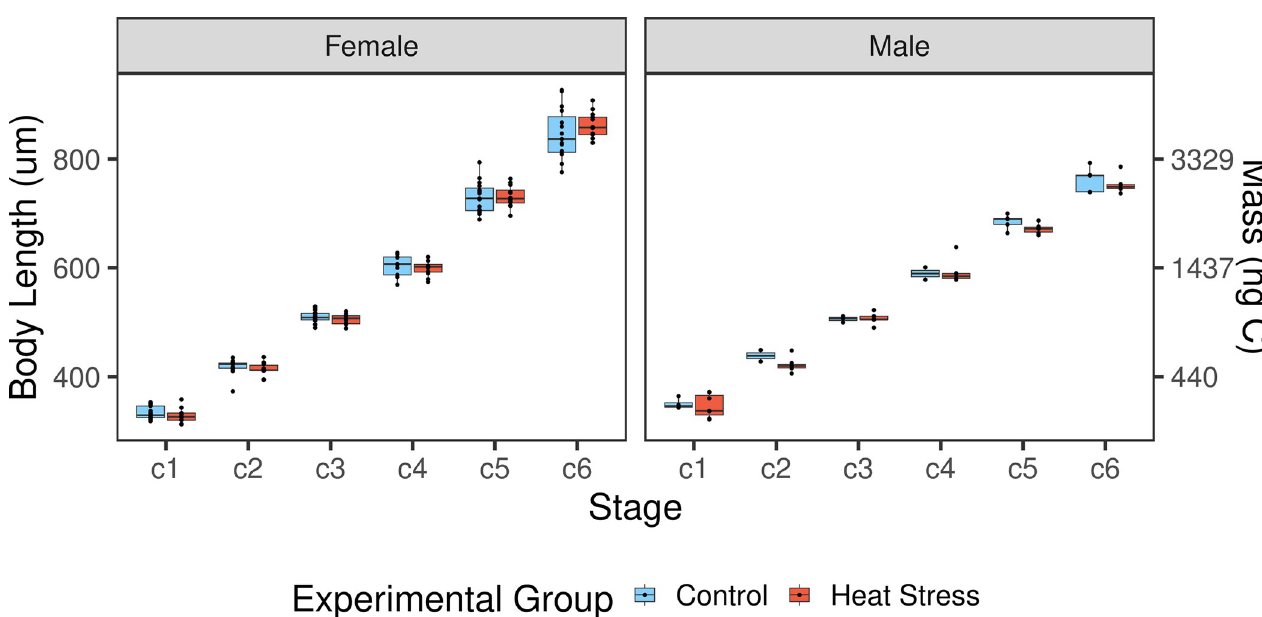
Fig 2. Stage specific body lengths of male and female Acartia tonsa copepodites. Body lengths (mm) for individuals from each experimental group at the various copepodite stages. Different treatments are indicated by fill color. Individual body size measurements are shown as points. Box plot components as in Fig 1B.